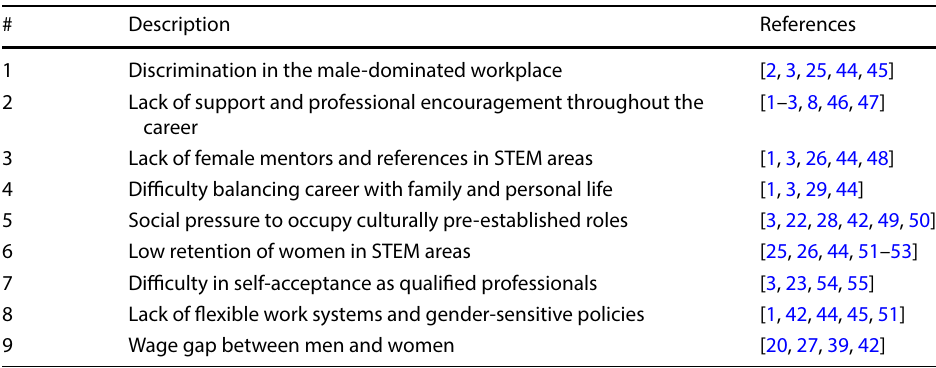
Table 1 Difficulties experienced by women in STEM areas